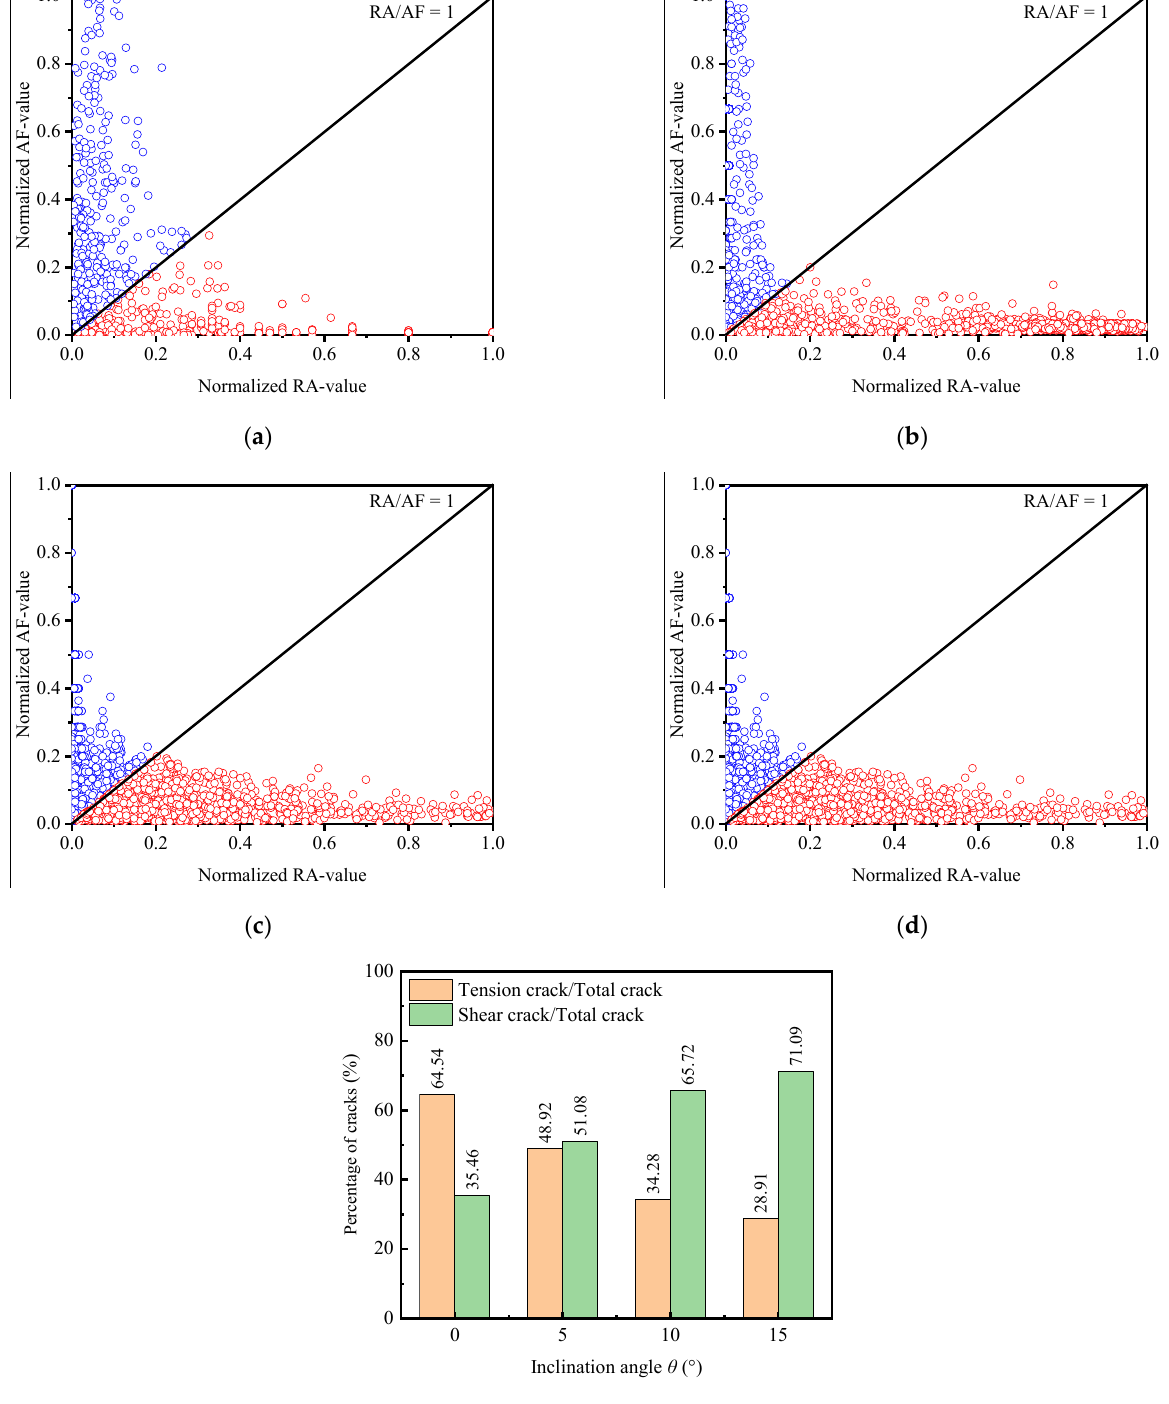
Figure 9. Evolution law of tension–shear crack of coal specimens under different inclination angles ( ω = 2.42%). ( a ) θ = 0°; ( b ) θ = 5°; ( c ) θ = 10°; ( d ) θ = 15°; ( e ) The proportion of tension–shear cracks in coal specimens under different inclination angles.